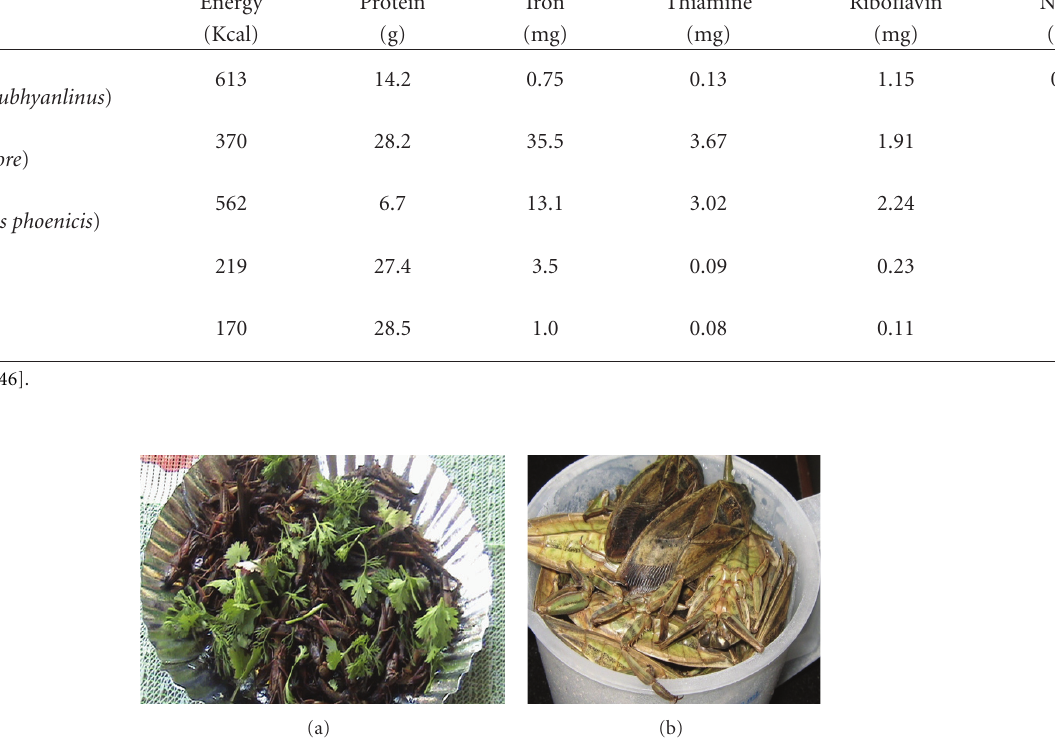
Figure 3: (a) Traditional dish form of grasshopper, Oxya hyla hyla from North-East India, and (b) Edible giant water bug, Belostoma indica